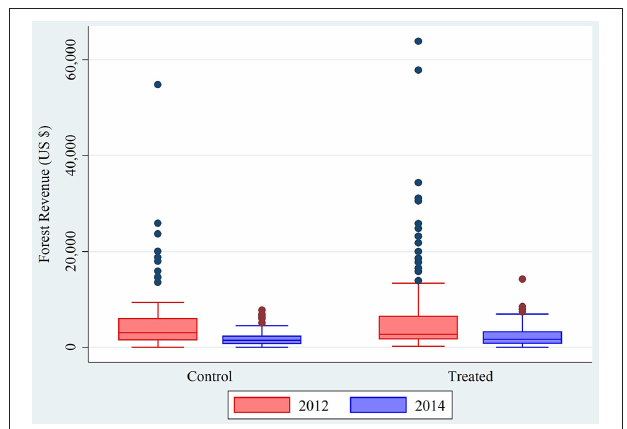
FIGURE 3 | Box plot for forest revenue—Ucayali site.